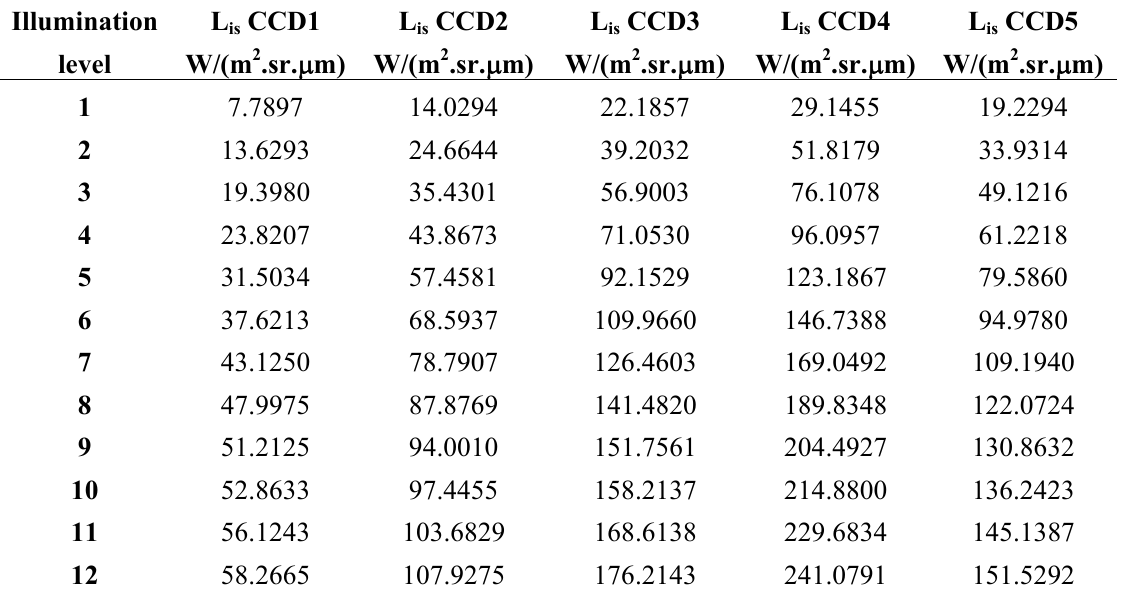
Table 1. Radiance (Lccd ) values in W/(m 2 .sr. μ m) that were associated to the homologous i DN values.